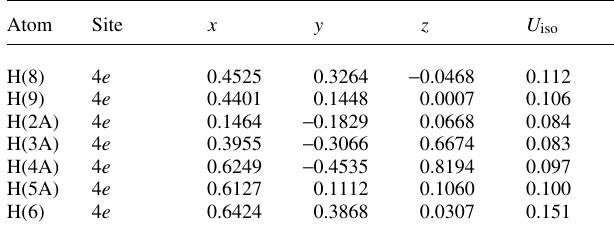
Table 2. Atomic coordinates and displacement parameters (in Å 2 )